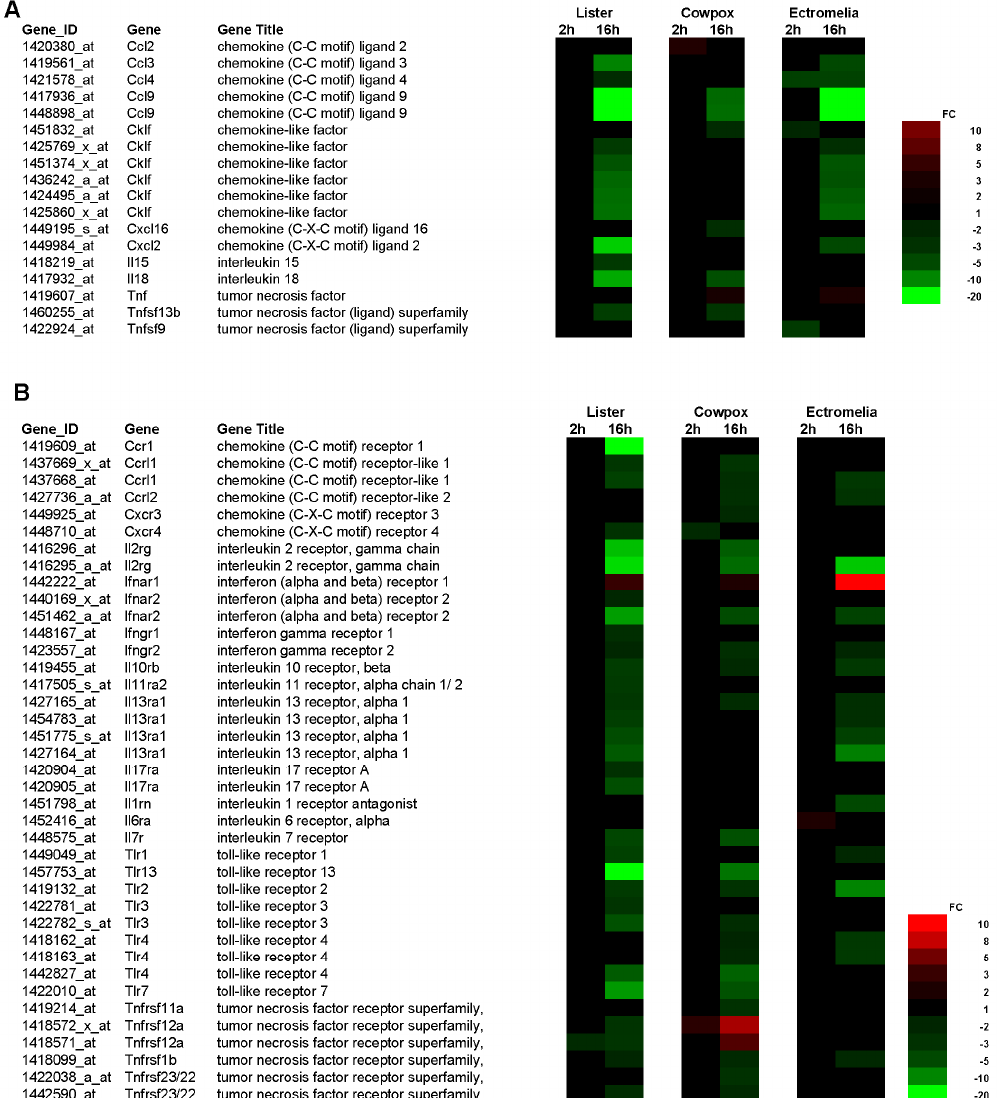
Figure 4. Changes in cytokine gene expression profiles in RAW cells infected with CPXV (cowpox), ECTV (ectromelia) and VACV (vaccinia virus; Lister). The fold change (FC) in cytokine gene expression involving cytokine ligands ( A ) and the cytokine receptors ( B ) at 2 and 16 h post infection (h) is presented as a heat map. The FC, gene identification (Gene ID), and gene name (Gene Title) are indicated.